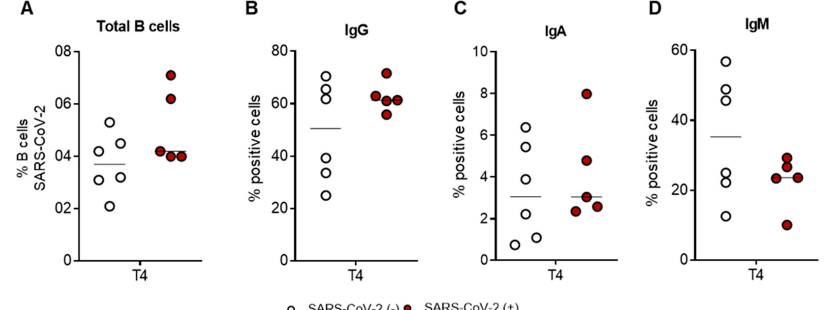
Figure A1. Percentage (%) of SARS-CoV-2-specific B cells between uninfected SARS-CoV-2 ( − ) (n = 6) and recovered SARS-CoV-2 (+) (n = 5, red dots) vaccinated subjects six months (T4) after the third booster dose ( A ). Comparison of the percentage (%) of positive cell-to-surface immunoglobulin isotypes IgG ( B ), IgA ( C ), and IgM ( D ) at T4. SARS-CoV-2 ( − ) are uninfected subjects (white dots), and SARS-CoV-2 (+) are recovered (red dots) vaccinated subjects. Significance was determined using Mann–Whitney test and t -tests.